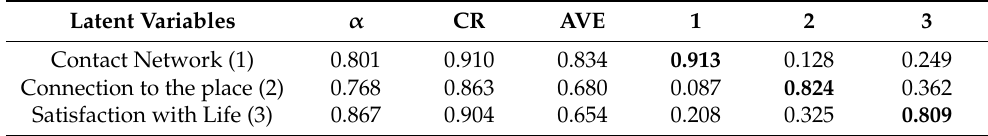
Table 1. Composite reliability, average variance extracted, correlations, and discriminant validity